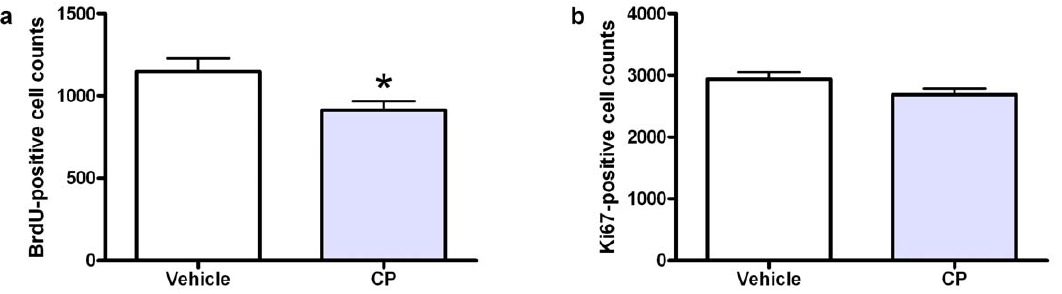
Figure 3. BrdU and Ki67-positive cell counts. Total number of BrdU -positive (a) and Ki67-positive (b) cells in the dentate gyrus (mean 6 SEM) estimated from cell counts. Rats receiving CP had significantly fewer BrdU-positive cells ( p , 0.05) than the saline-treated control group. No significant difference was found between groups for the total numbers of Ki67-positive cells.